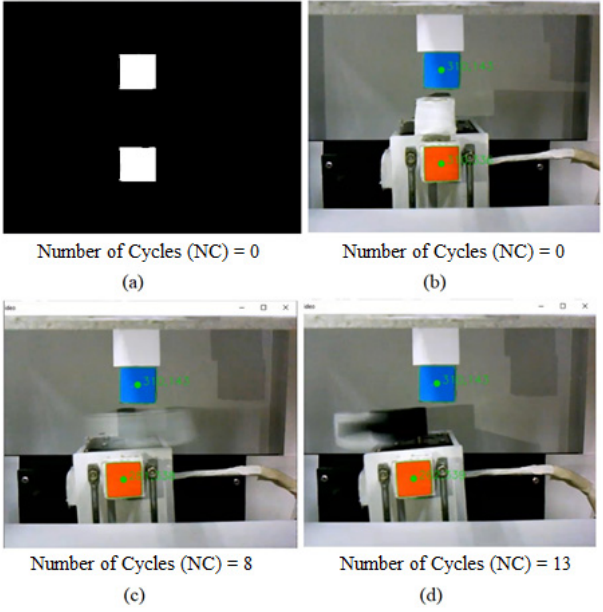
Figure 6. Operativity of the artificial vision identifying colors and shapes. The algorithm marked the contour and the centroid in pixels of the static and dynamic targets. The coordinates increased from the upper-left corner of each video frame: ( a ) Morphologic identification; ( b ) before the test; ( c ) test after eight cycles; and ( d ) test after 13 cycles. Ottawa sand sample (testing performed under 5.86 Hz and 0.2 mm).